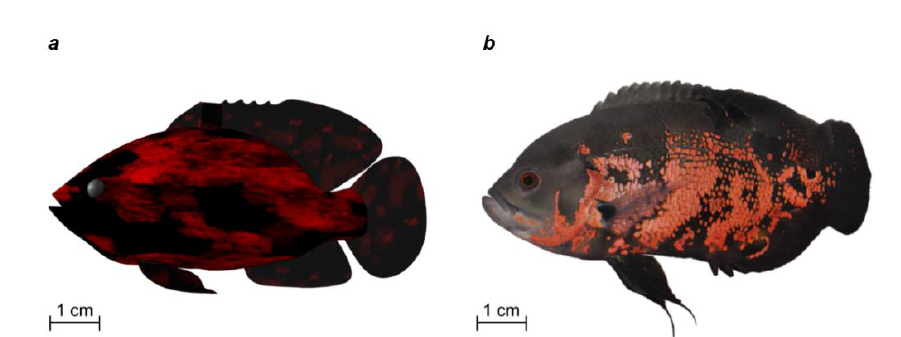
Figure 6 . Stimuli used in the fear-evoking test. (a) Painted 3D-printed model of a red tiger oscar fish and (b) its live counterpart. [Reproduced from (Neri et al., 2017)].